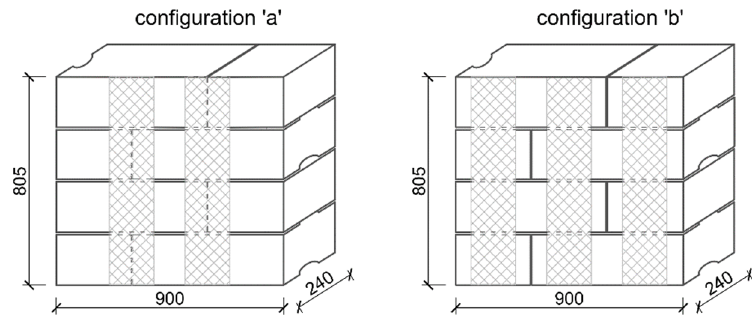
Figure 2. Two arrangements of the FRP strengthening. Table 2. Main strength parameters of FRP strengthening.